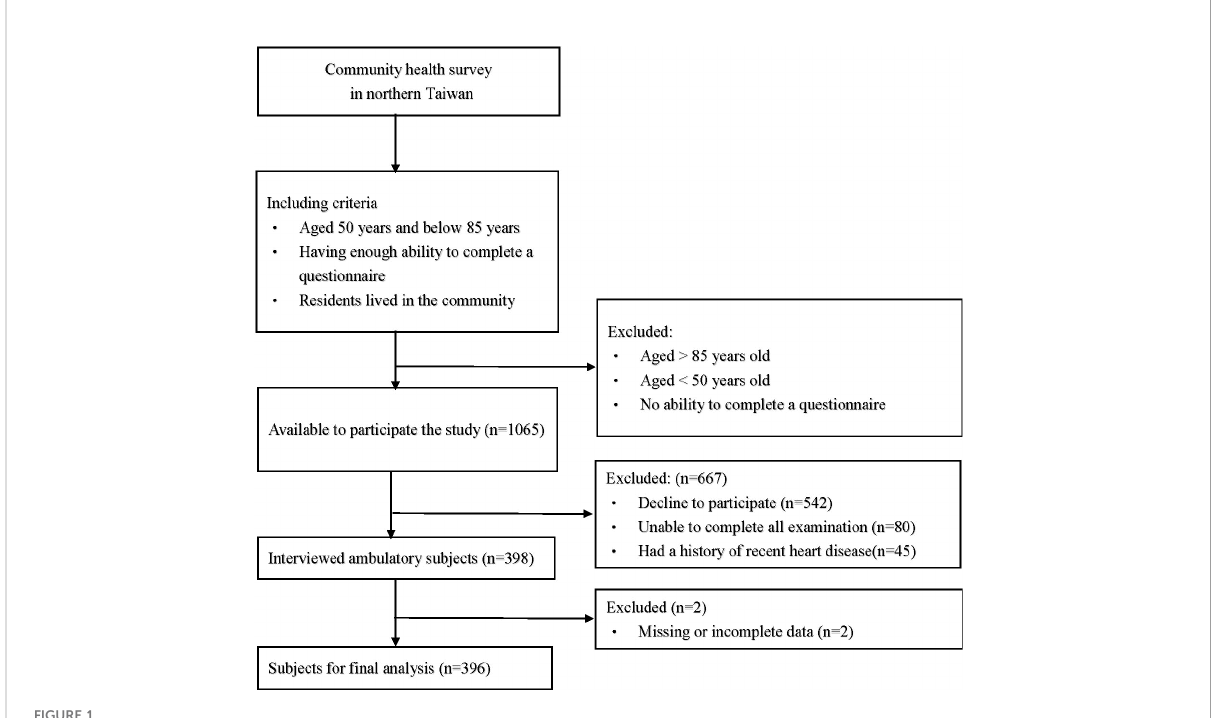
FIGURE 1 Flow chart of study